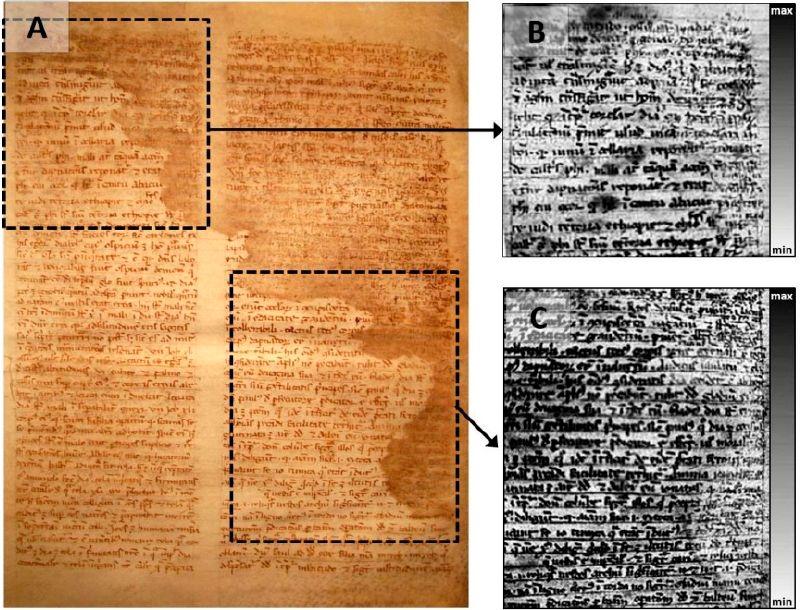
Figure 8. XIII century manuscript “ms 509/D813”, Biblioteca Angelica of Rome. ( A ) Photograph of folio 124 verso ; ( B , C ) thermograms of the areas indicated by the dashed rectangles in Figure 8A. For ease of viewing and to better compare the thermographic results with the photographic image, the thermograms are presented with an inverted grey palette.